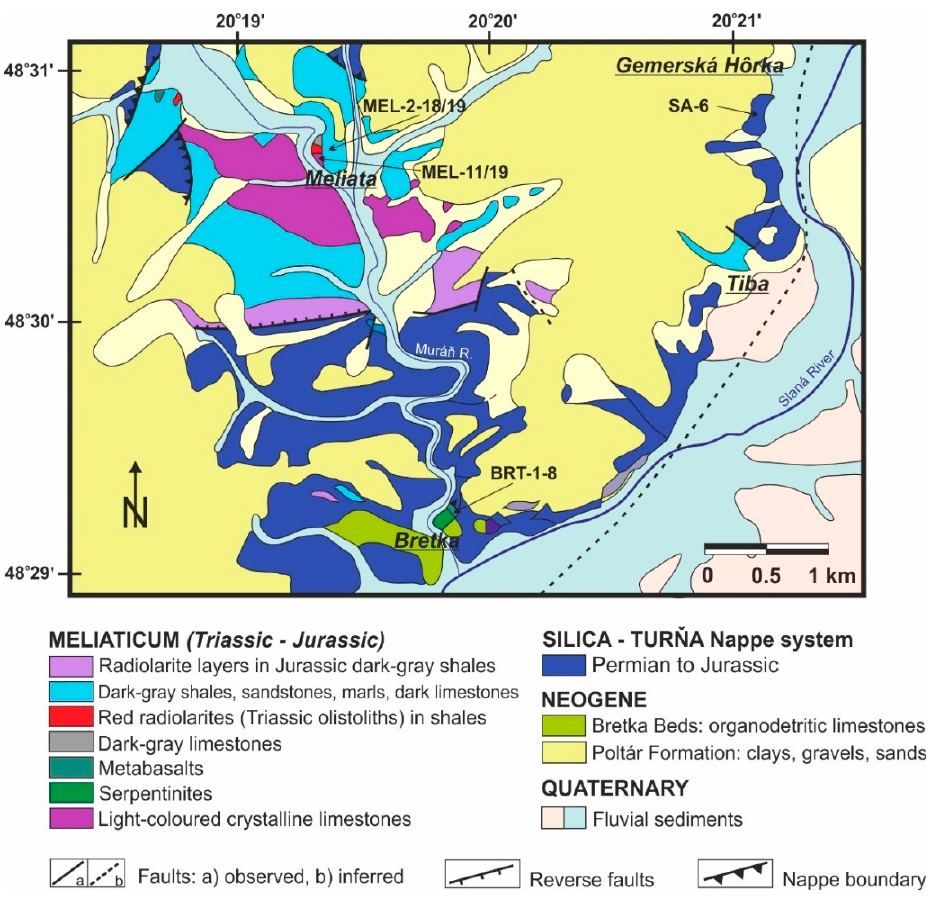
Figure 4. Schematic geological map of Meliata, Bretka and Gemerská Hôrka areas modified from [52]. The Meliaticum occurs in tectonic windows below the Silica–Tur ň a nappe system.